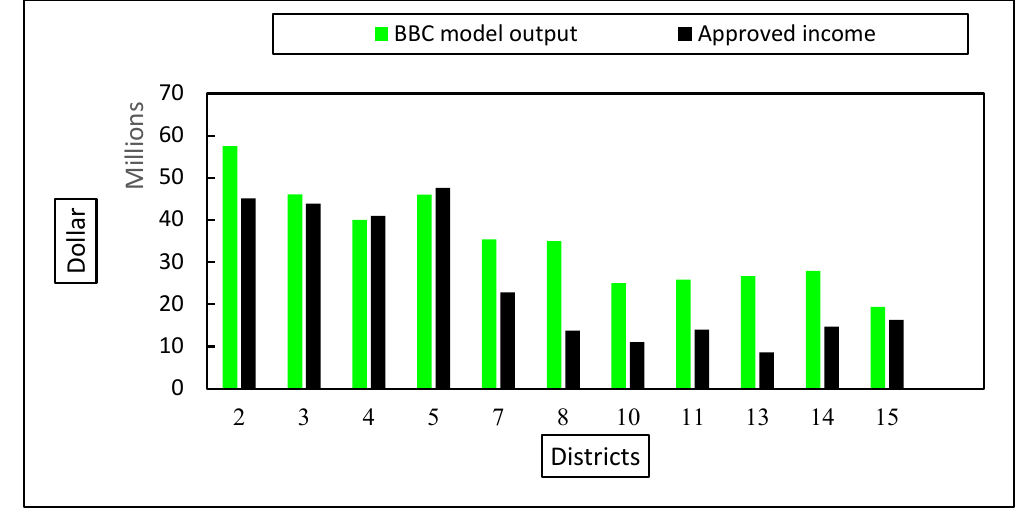
Fig. 5: The proposed value of BCC-O model vs approved sustainable income